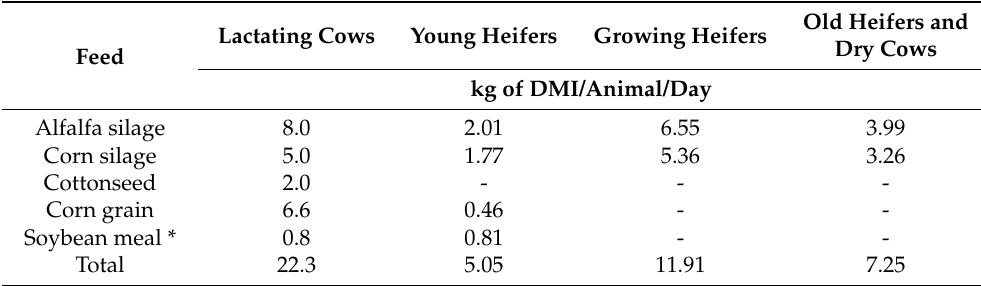
Table 1. Diet composition of the large farm (1000 Holstein lactating cows) for lactating and nonlactat- ing cows grouped into young heifers (1–10 months), growing heifers (11–21 months), and old heifers (>21 months) and dry cows